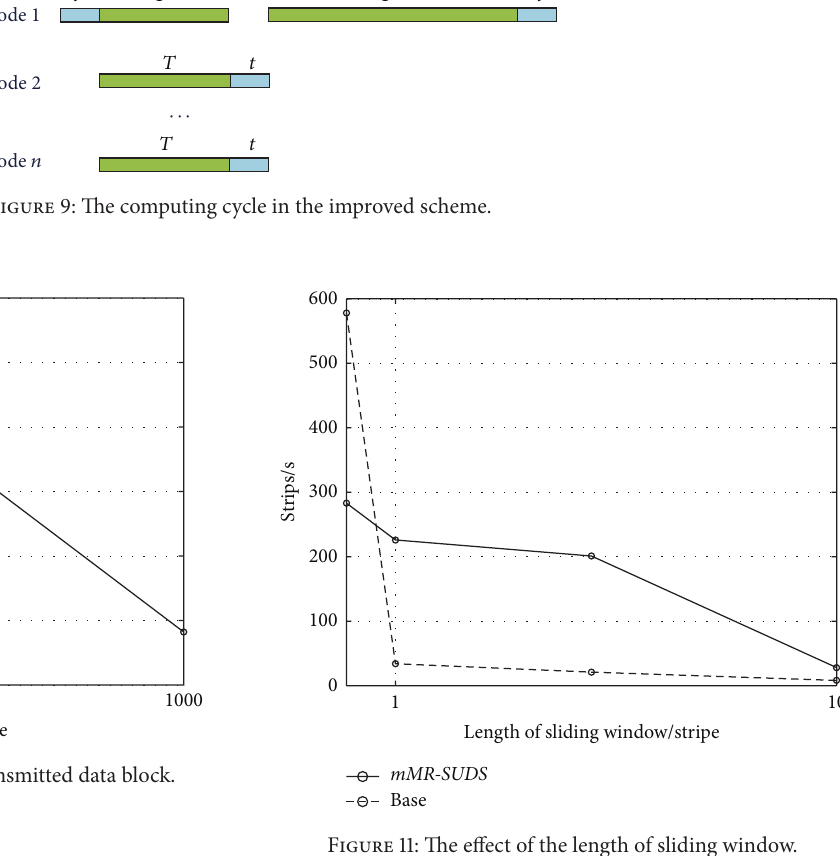
Figure 11: The effect of the length of sliding